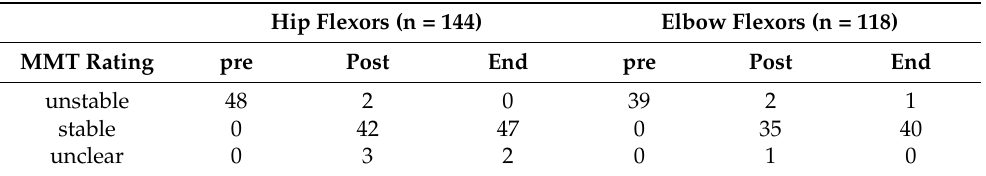
Table 1. Subjective ratings of the manual muscle tests by the testers. The number of MMTs assessed as unstable, stable or as unclear for hip and elbow flexors for each time point is